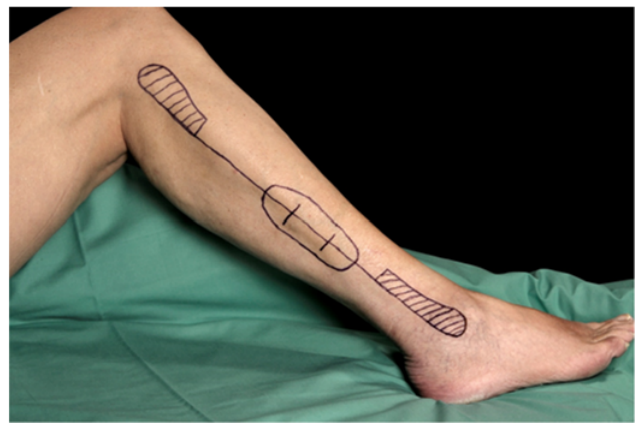
Figure 7. Preoperative marking of the donor site on the right leg. A safety distance of at least 8 cm should be maintained both to the fibular head and to the lateral malleolus (marked as dashed areas). The longitudinal line marks the posterior edge of the fibular bone, the origin of the posterior inter ‐ muscular septum that contains the septocutaneous perforators. Based on the preoperative imaging, the perforators are marked (typical location in the third quarter of the fibula). The skin island is outlined dependent on the location of the perforators such that at least one strong perforator is cer ‐ tainly included.